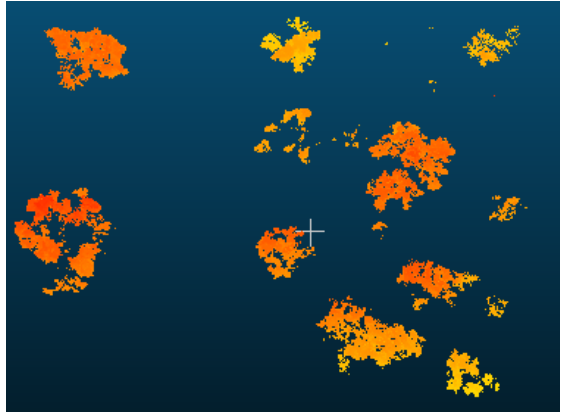
Figure 10.The extraction of non-ground seed points using CSF in the measured area by setting cloth resolution of 2